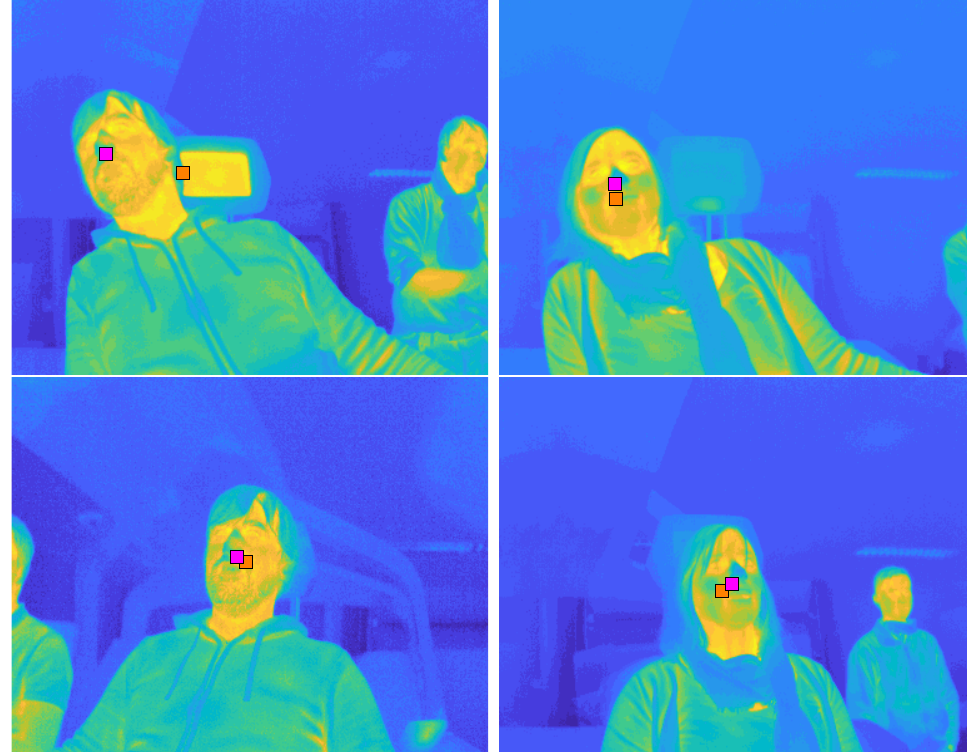
Figure 8. Four colormapped LWIR pictures with reference (magenta) and detection (orange) points using the original image size of 382 288 pixel. Warm regions are displayed in yellow colour and × colder regions are colored blue. In the first picture on the top left the headrest is heated up and the detected point is between the actual head and the heated area. The top left and bottom right picture show examples of people standing in the background.